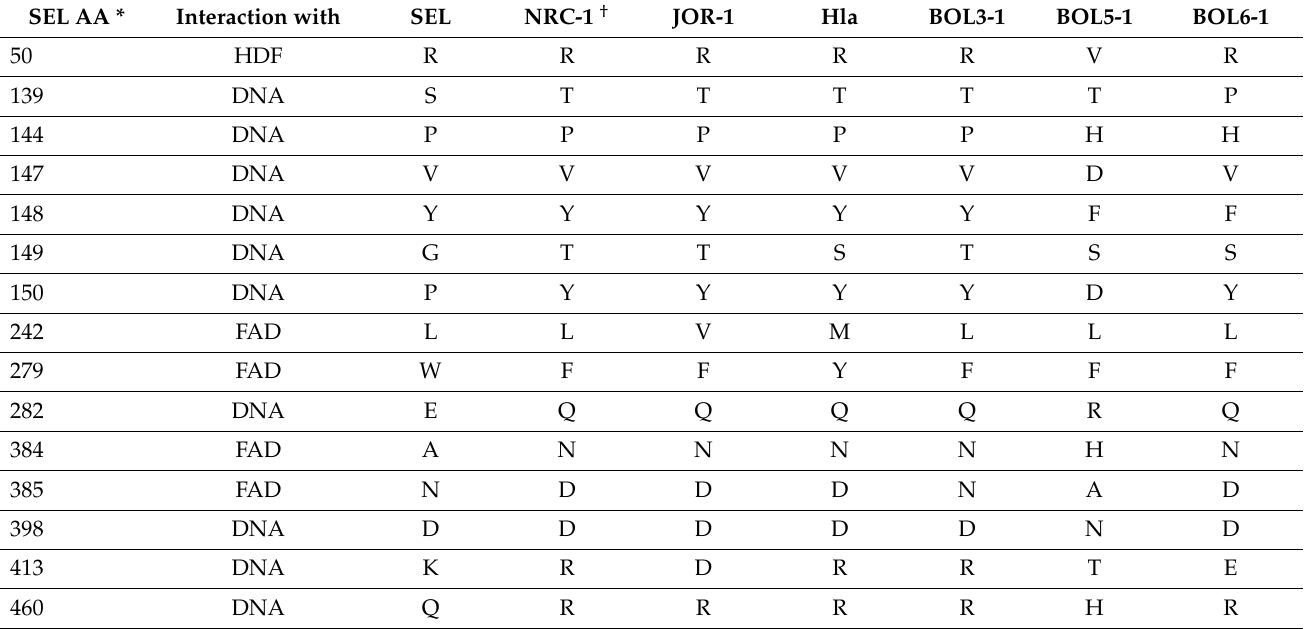
Table 2. Key amino acid residues of S . elongatus PCC 6301 photolyase compared to Phr2 proteins of diverse